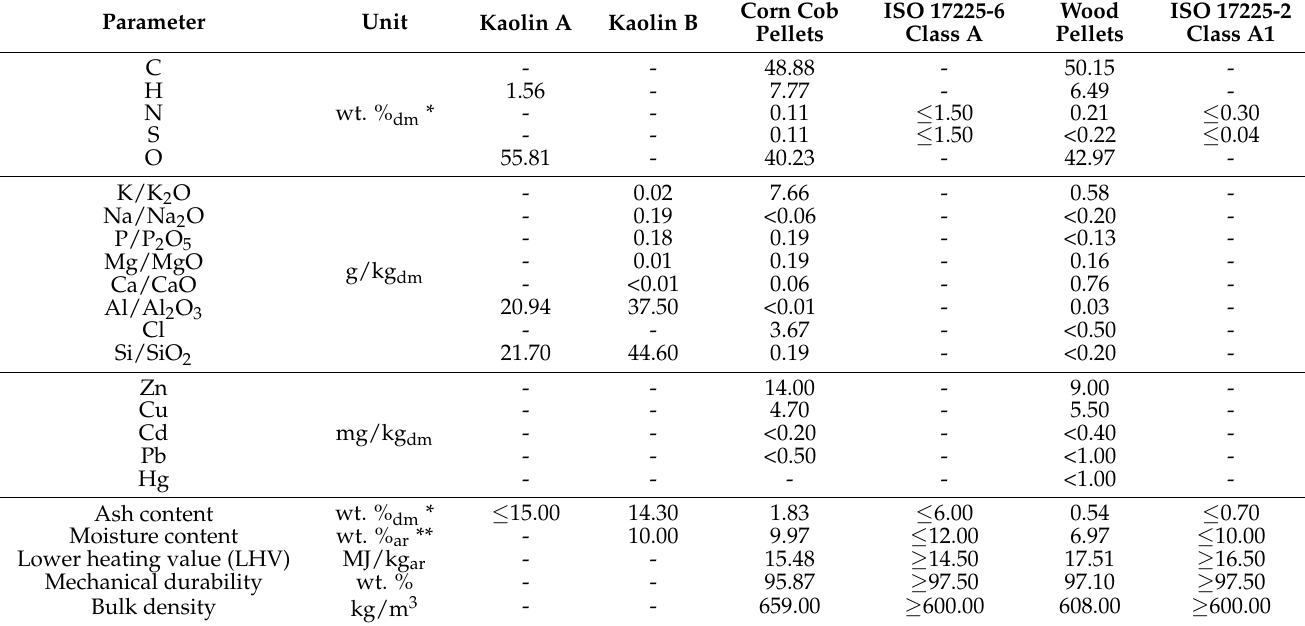
Table 1. Elementary composition of the feedstock and additives (* dm—dry matter, ** ar—as received). Parameter